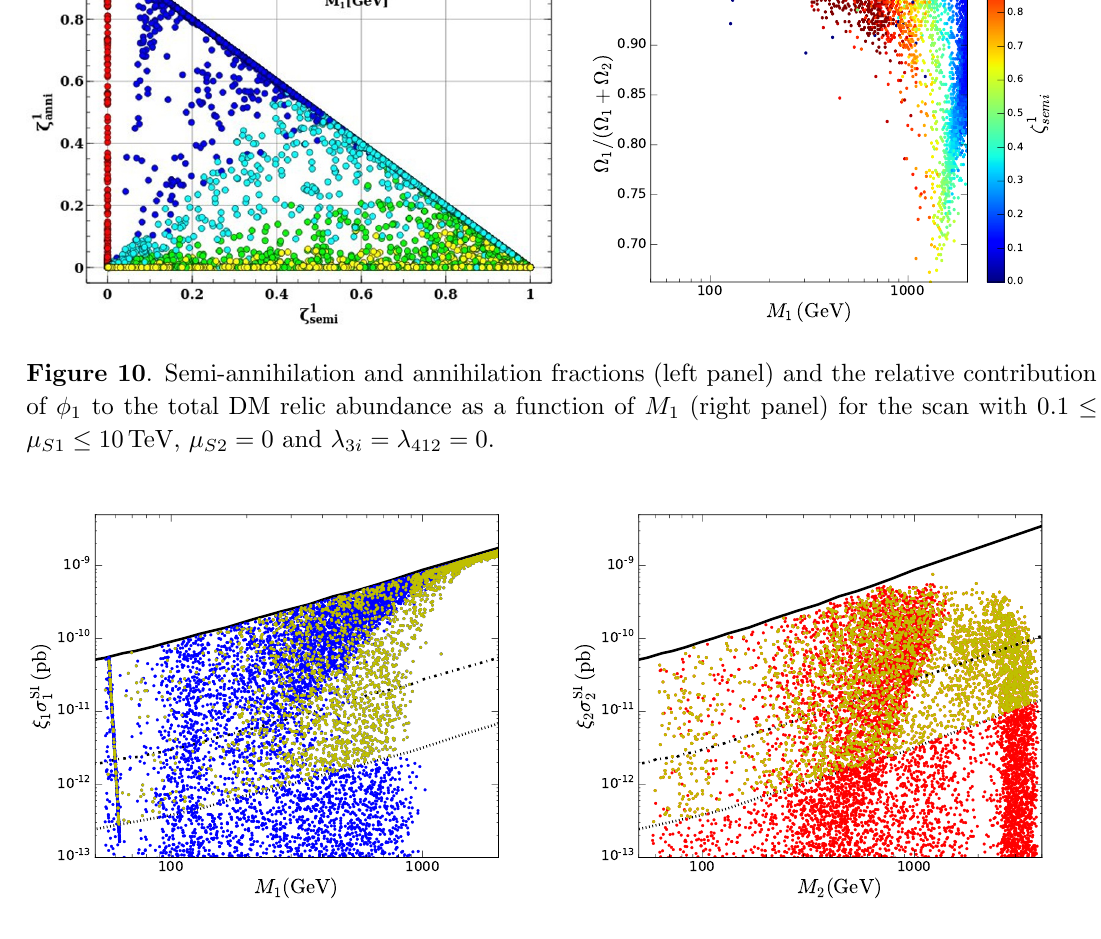
Figure 11 . Spin-independent cross-sections for elastic scattering of (cid:30) i with nuclei scaled by (cid:24) i in the scan with (cid:22) S 1 6 = 0. The solid line is the upper limit set by XENON1T collaboration [25] while the dot-dashed and dotted lines show the projected sensitivity of LZ [26] and DARWIN [27] experiments. Yellow points indicate that both DM particles lay within the sensitivity region of